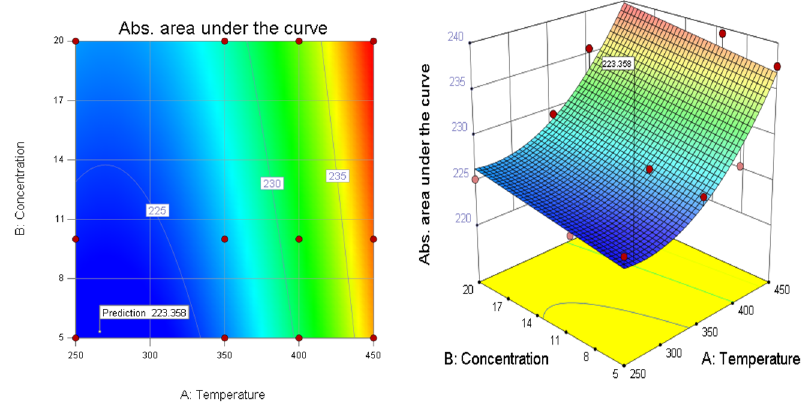
Figure 3. Contour and 3D curves for optimum design values for the modified quadratic model.